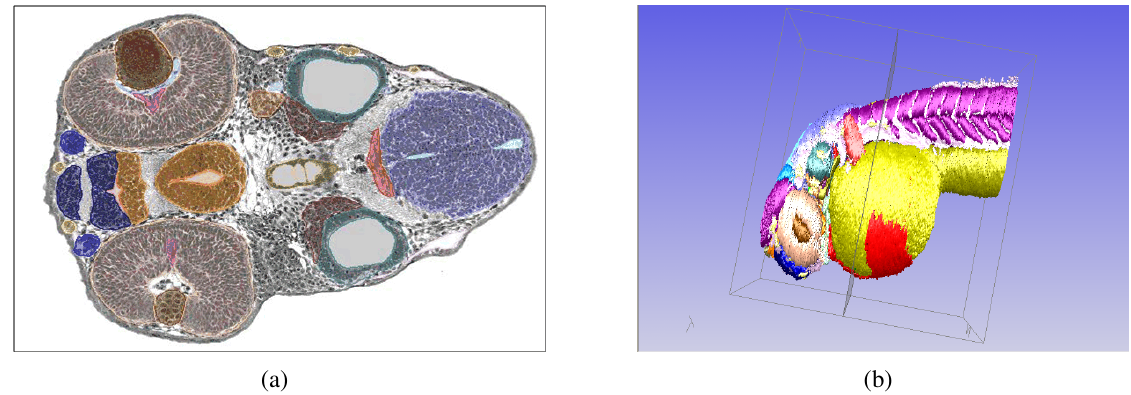
Figure 2: A 48 hpf zebrafish embryo from the 3D atlas. (Left) 2D section where each anatomical structure is annotated semantically with an anatomical term from the DAOZ and graphically by a contour. (Right) The 3D model resulting from 3D reconstruction from serial